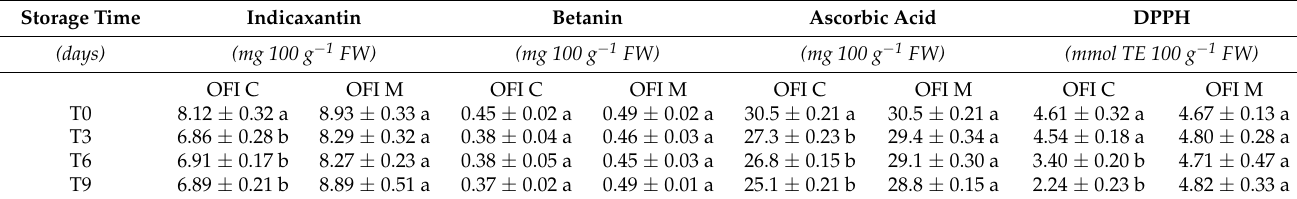
Table 2. Changes in Indicaxantin, Betanin, Ascorbic Acid and DPPH in minimally processed O. ficus-indica fruits non-treated (OFI C) and treated with mucilage (OFI M) during cold storage (9 days at 5 ◦ C). Different lowercase letters indicate significant differences at p ≤ 0.05 between the treatments in each sampling date. Data are the mean ± SE ( n = 5). Storage Time Indicaxantin Betanin Ascorbic Acid DPPH